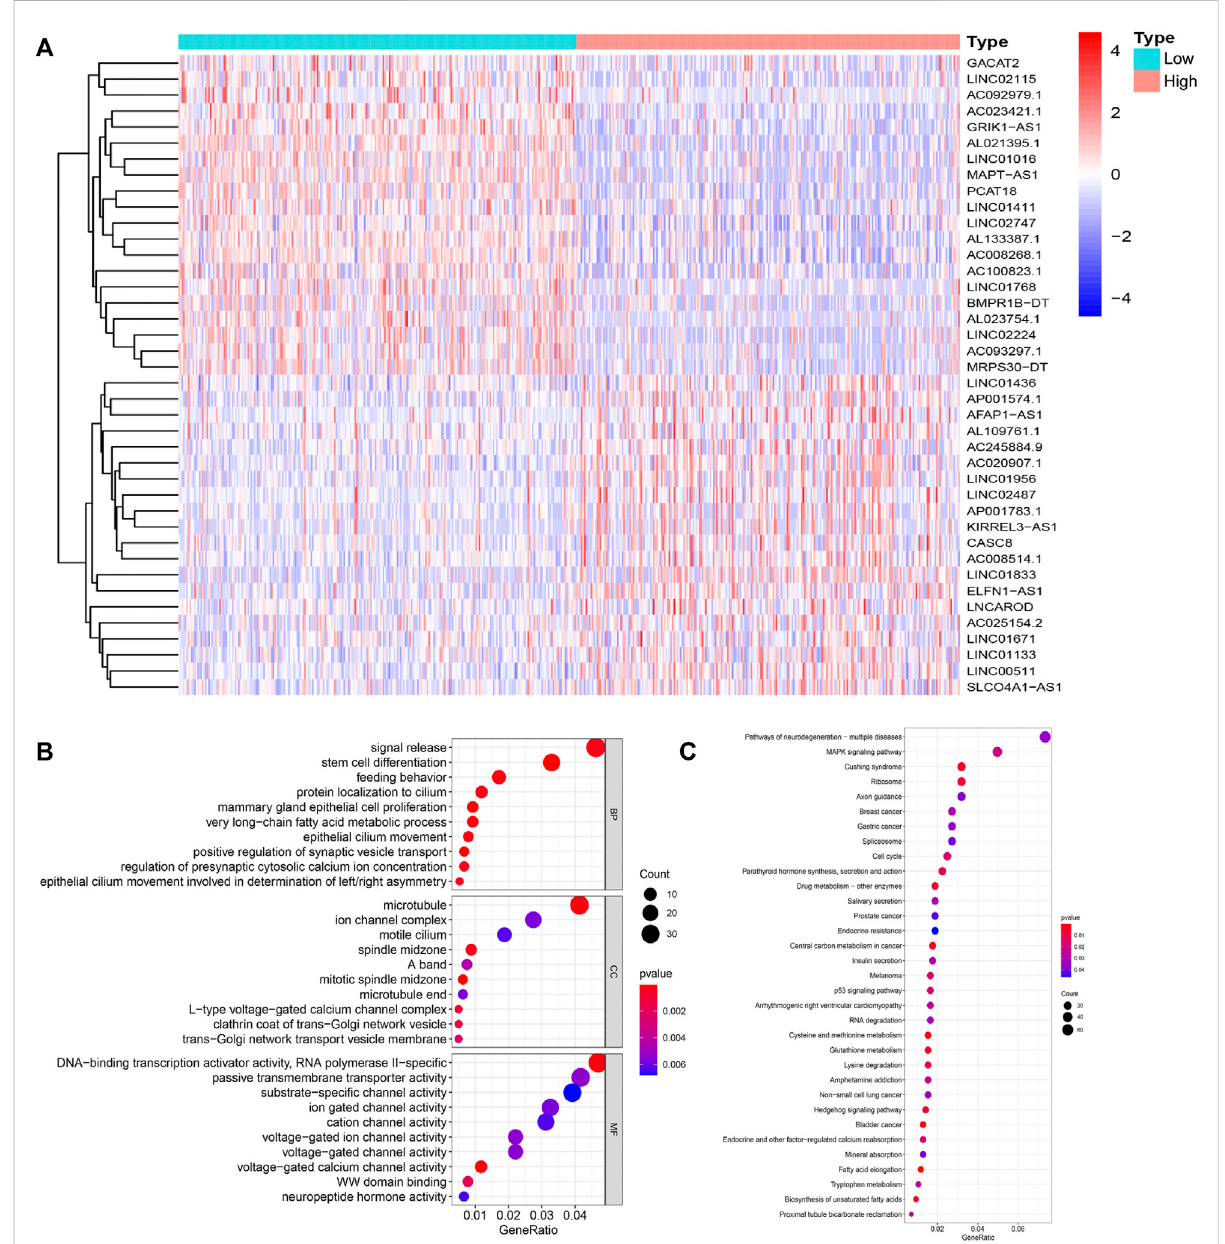
FIGURE 1 Identi fi cation and functional annotations of genetic instability-related lncRNAs in breast cancer patients. (A) . Differentially expressed lncRNAs between the High group and the Low group. Patients with the lowest 25% mutation frequency were regarded as the Low group ( n = 253). Patients withthehighest25%mutationfrequencywereregardedastheHighgroup( n =244).|LogFC| > 1andFDR < 0.05wereusedasthecriteriaforscreening differentially expressed lncRNAs. Red means upregulated and blue means downregulated. (B) . Functional enrichment analysis of GO for lncRNAs co-expressed mRNAs. (C) . Functional enrichment analysis of KEGG for lncRNAs co-expressed